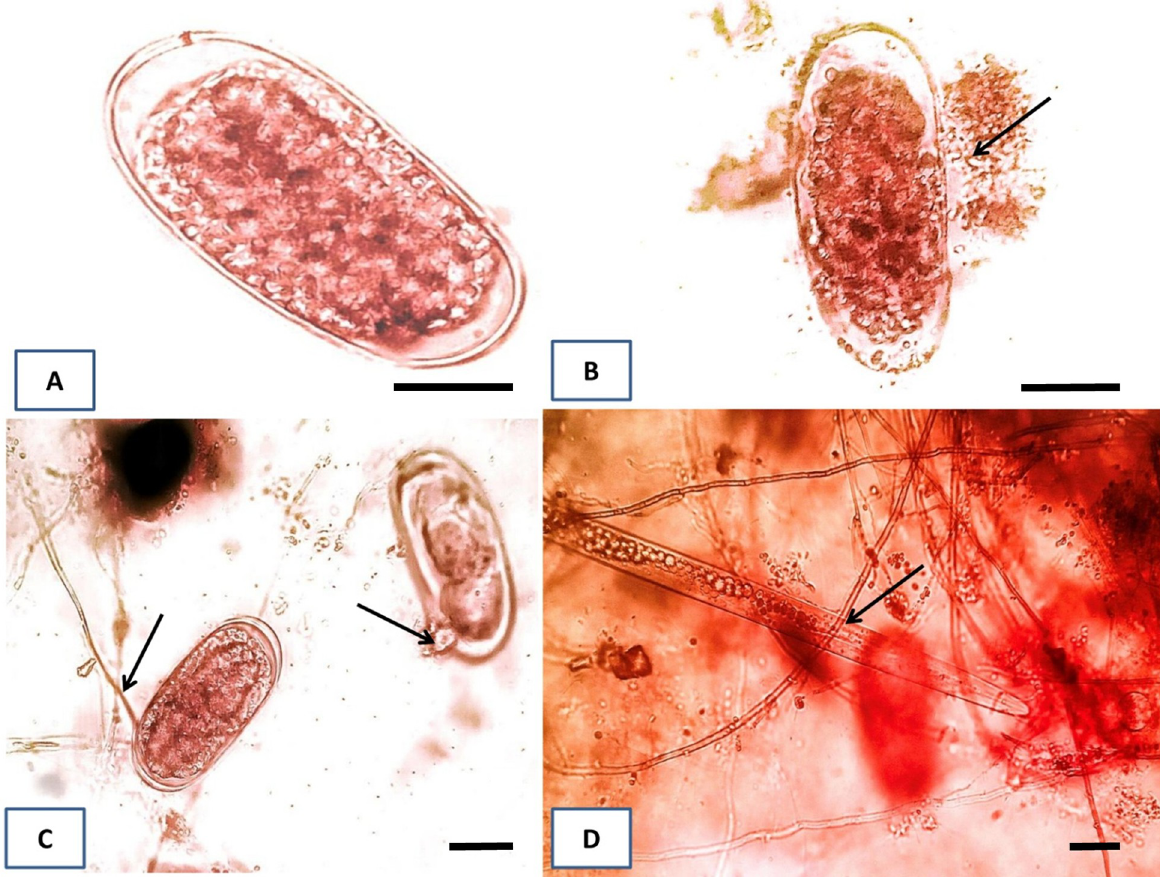
Fig 4. Direct effects of P . lilacinum on M . incognita eggs and juveniles. Microscopic observation was performed during the incubation of P . lilacinum with M . incognita eggs (B and C) and juveniles (D) on PDA agar plates. A intact egg was shown in (A). Arrows indicate penetration and aggregation of fungal conidia and mycelia in eggs (B and C) and attaching to a J2 juvenile (D). Scale bars = 50 μ m.